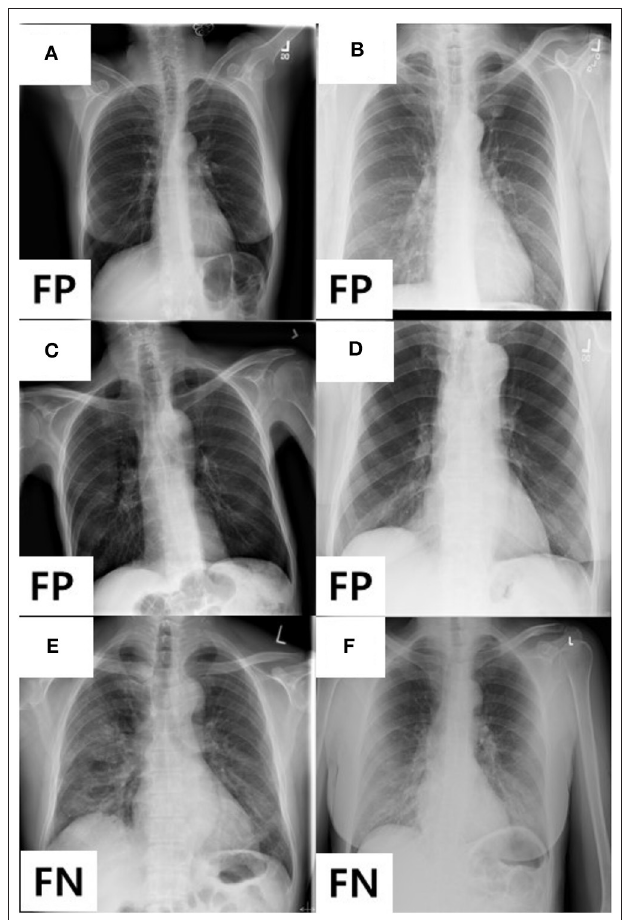
FIGURE 3 | Images showing four FPs predicted as COVID-19 and two FNs predicted as non-TB lung disease in AXIR4 results: infiltration (A–C) , pleural thickening (D) , and COVID-19 (E, F)